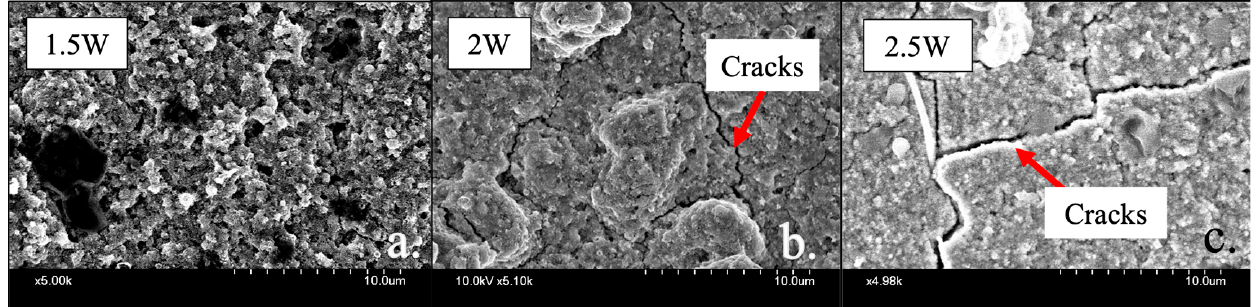
Figure 11. SEM morphologies of 1.5W sintered thin films with varied scanning speeds.